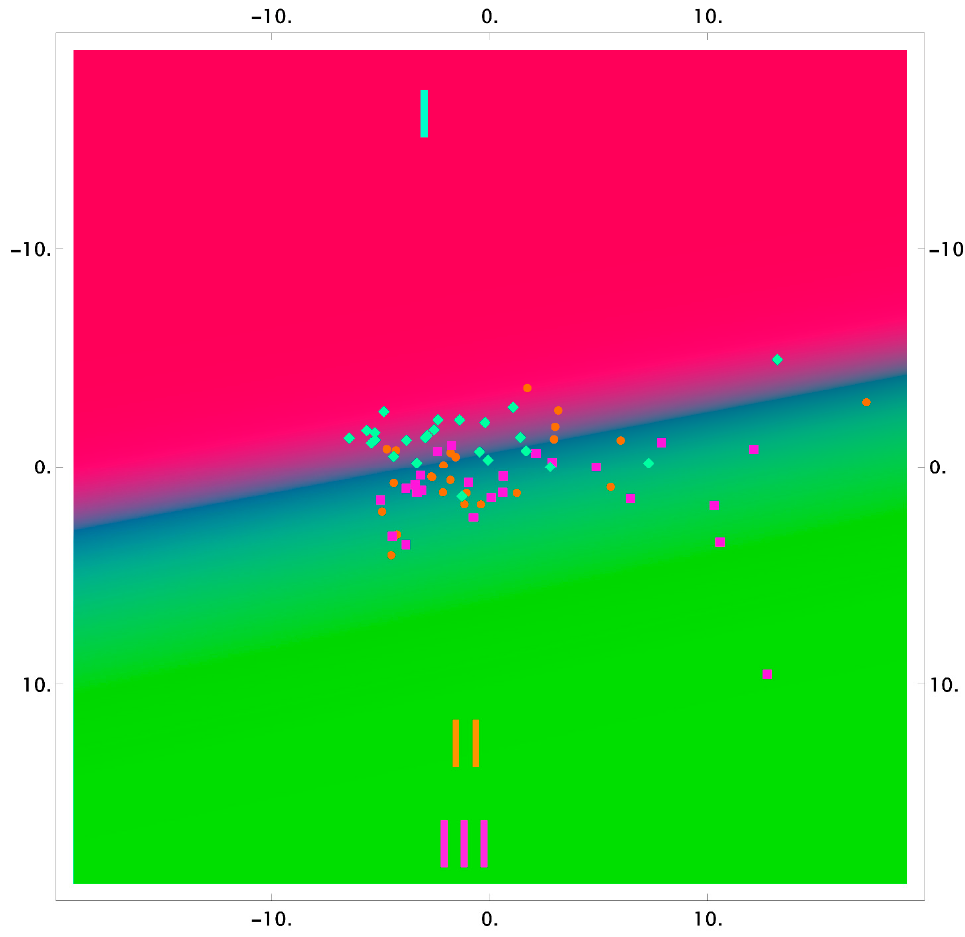
Figure 5. The 2D probability distribution of each class as a function of the features (cementum) of the studied groups I–III.